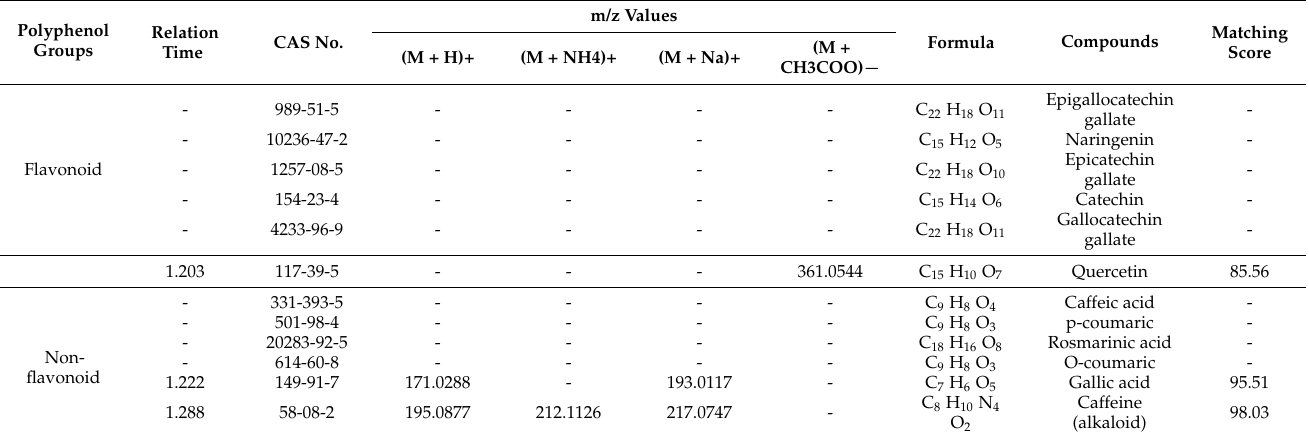
- Not able to be detected by quadrupole time-of-flight mass spectrometry